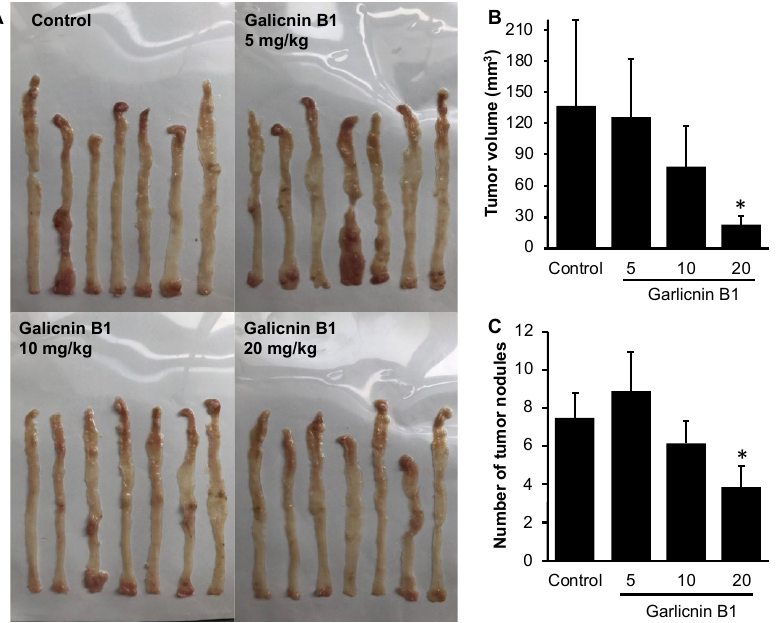
Figure 5. Inhibitory effect of garlicnin B1 on colon carcinogenesis in mice treated by azoxymethane (AOM)/dextran sulfate sodium (DSS). ( A ) shows representative pictures of the colon from different experimental groups, ( B ) shows the cumulative size of tumor nodules in each mouse, and ( C ) shows the average number of tumor nodules in the colon. Values are presented as means ± standard deviation (SD); n = 7. * p < 0.05 versus the untreated control group. See text for details.